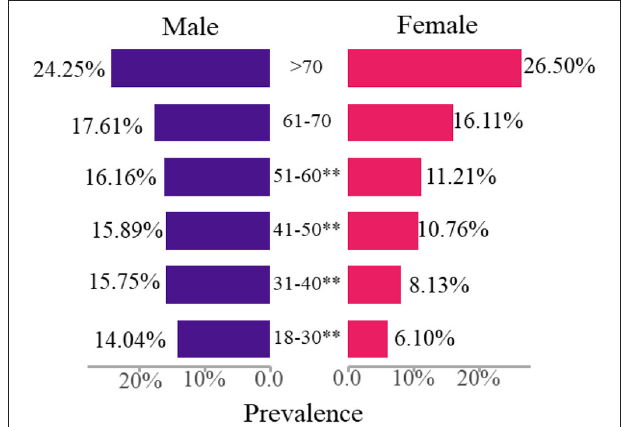
FIGURE 3 | The prevalence trend of critical values along with age for the male and female. **Denotes a statistically significant difference ( P < 0.01).